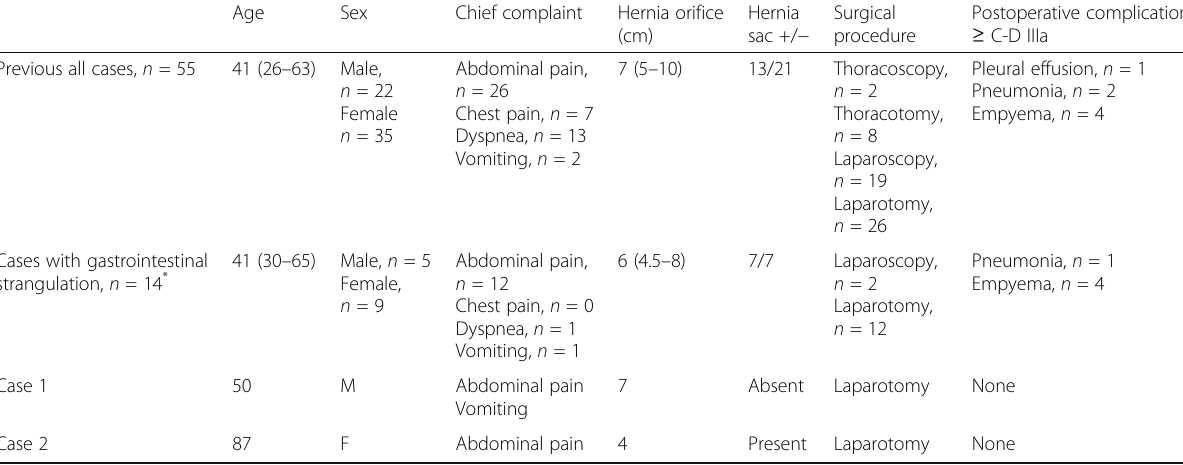
Table 1 Clinical features of 55 case reports and our